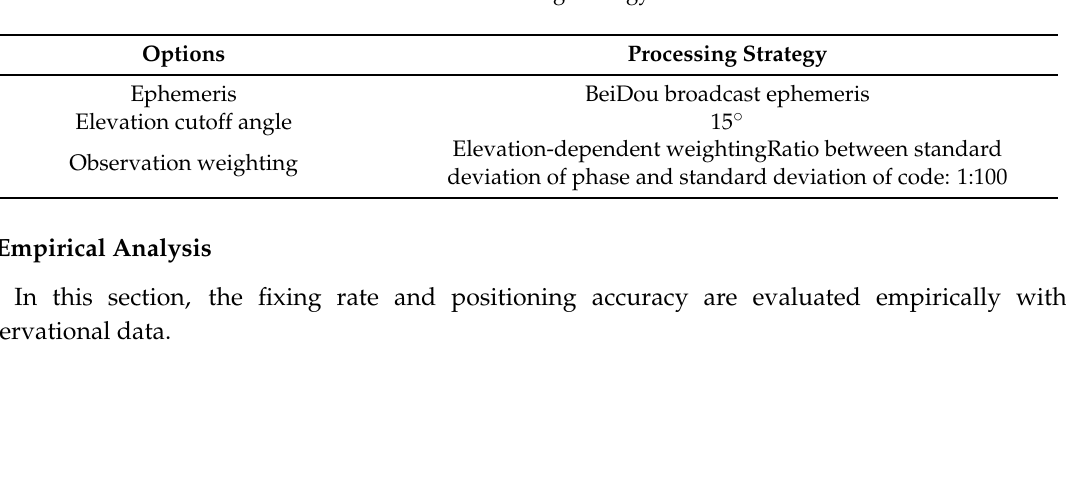
Table 7. Processing